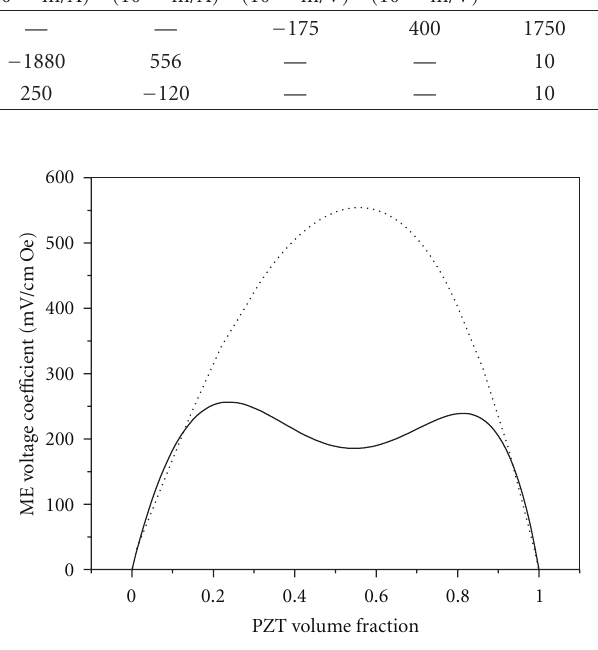
Table 1: Material parameters (compliance coe ffi cient s , piezomagnetic coupling q , piezoelectric coe ffi cient d , and permittivity ε ) for lead zirconate titanate (PZT), cobalt ferrite (CFO), and lanthanum strontium manganite used for theoretical values. Material